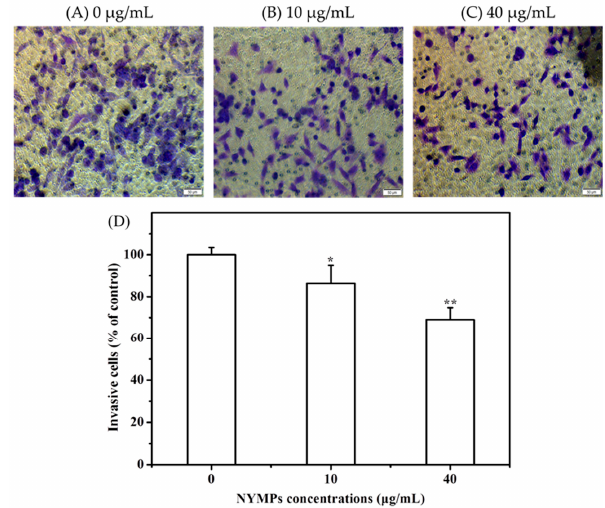
Figure 3. Effects of NYMPs on cell invasion of human breast cancer MCF-7 cells (Magnification × 200). ( A ) Images of cells treated without NYMPs. ( B ) Image of cells treated with 10 μ g/mL NYMPs. ( C ) Image of cells treated with 40 μ g/mL NYMPs. ( D ) Invasion ability. Each value represents the mean ± standard deviation ( n = 3). * p < 0.05 and ** p < 0.01 indicated statistically significant differences versus control group.